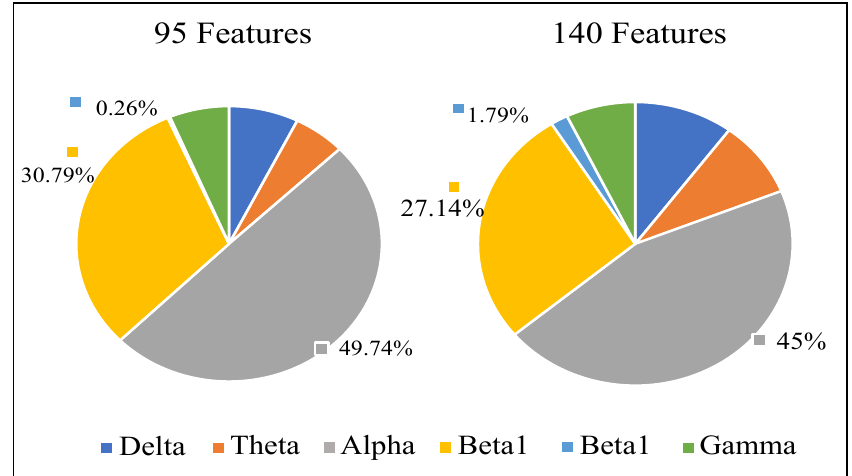
Figure 7. Percentage (%) of PLV features from different frequency bands in the features with first 95 and 140 sorted r 2 values